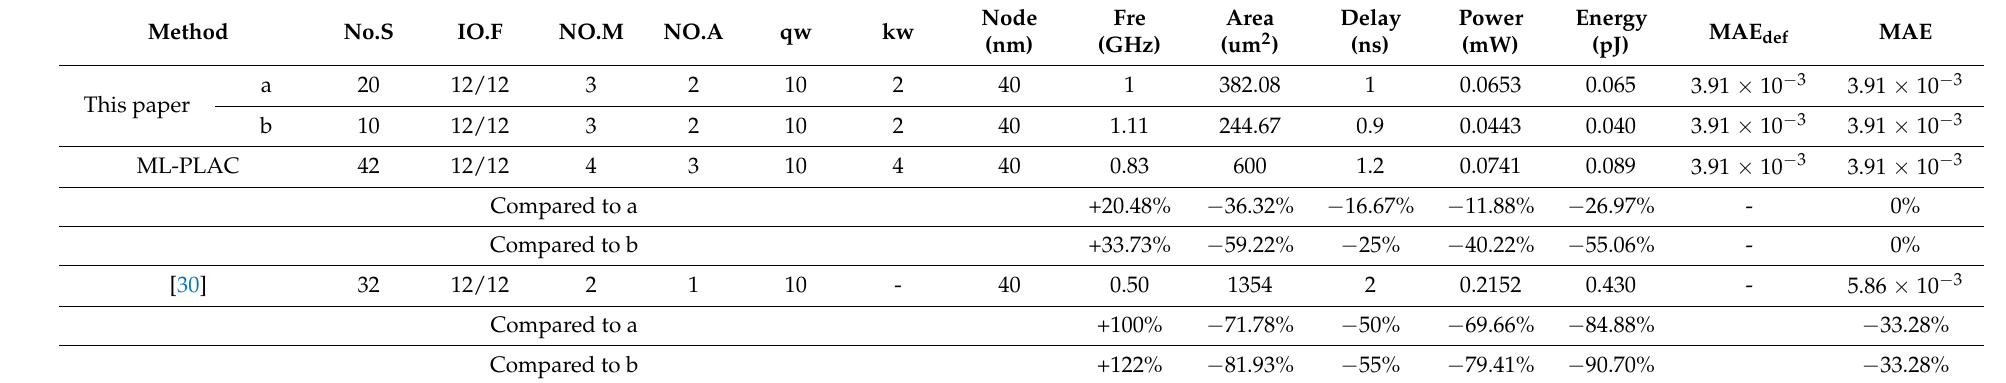
Table 9. Performance comparison for softsign ( x ) , x ∈ ( − 8,8 )